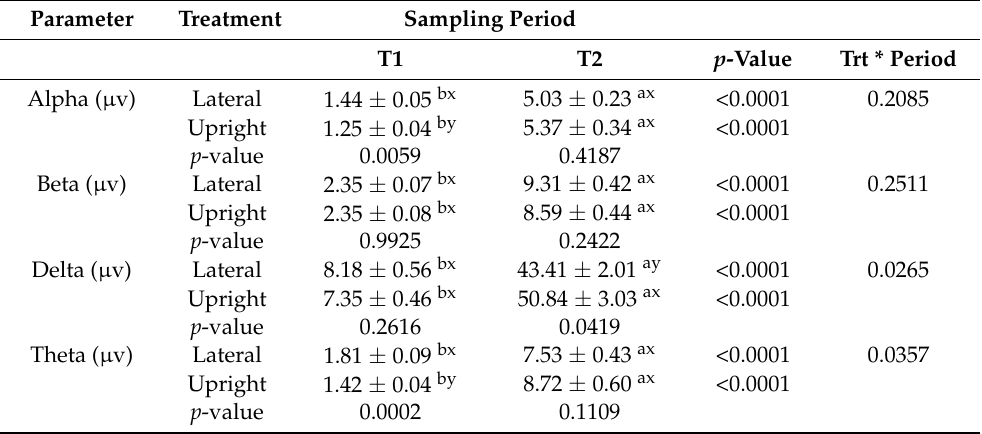
Table 3. Electroencephalographic changes in cattle subjected to slaughter positions before slaughter (T1) and after neck cut